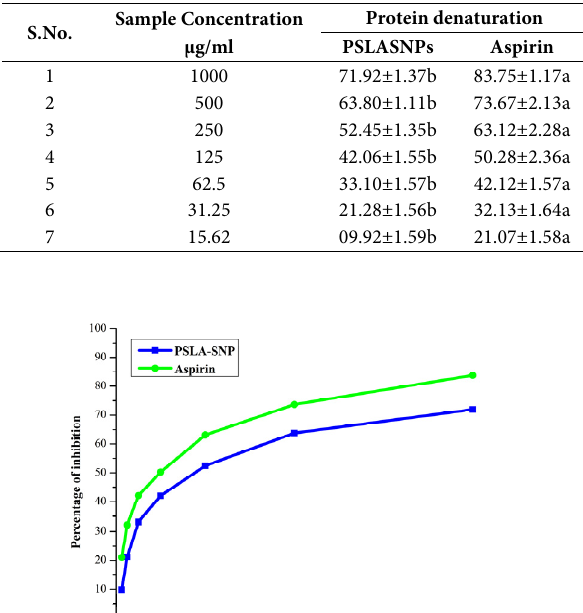
Table1. Anti-inflammatory activity of PSLASNPs sample